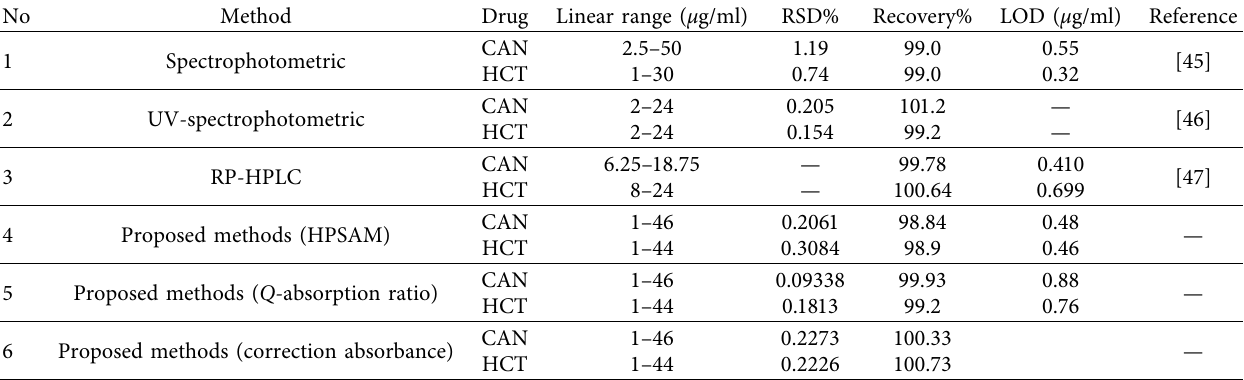
Table 19: Te review of the published work for simultaneous determination of drugs by diferent chemical